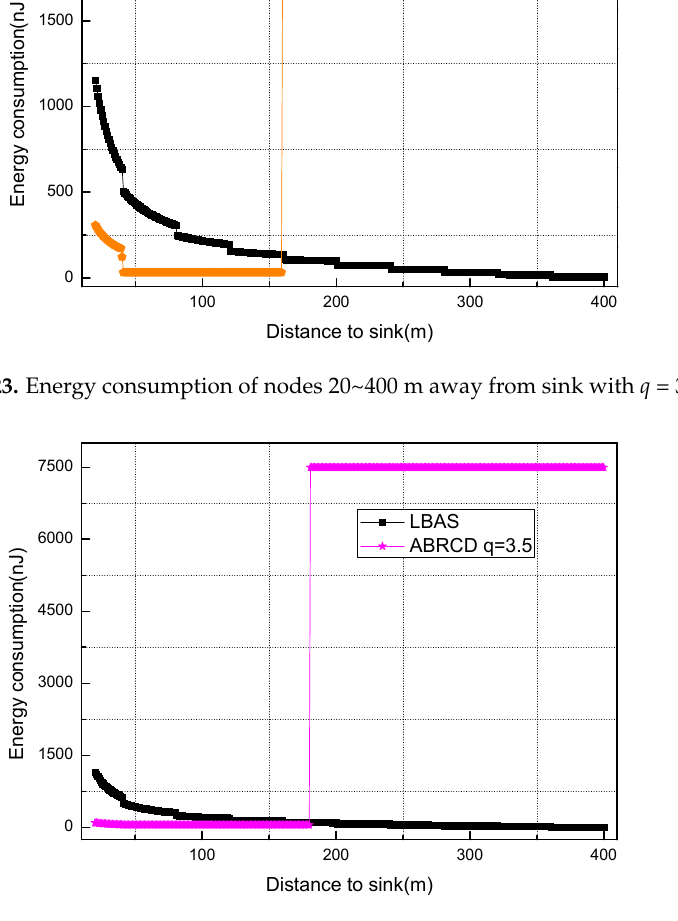
q LBAS ABRCD Figure 25. Lifetime with different q.